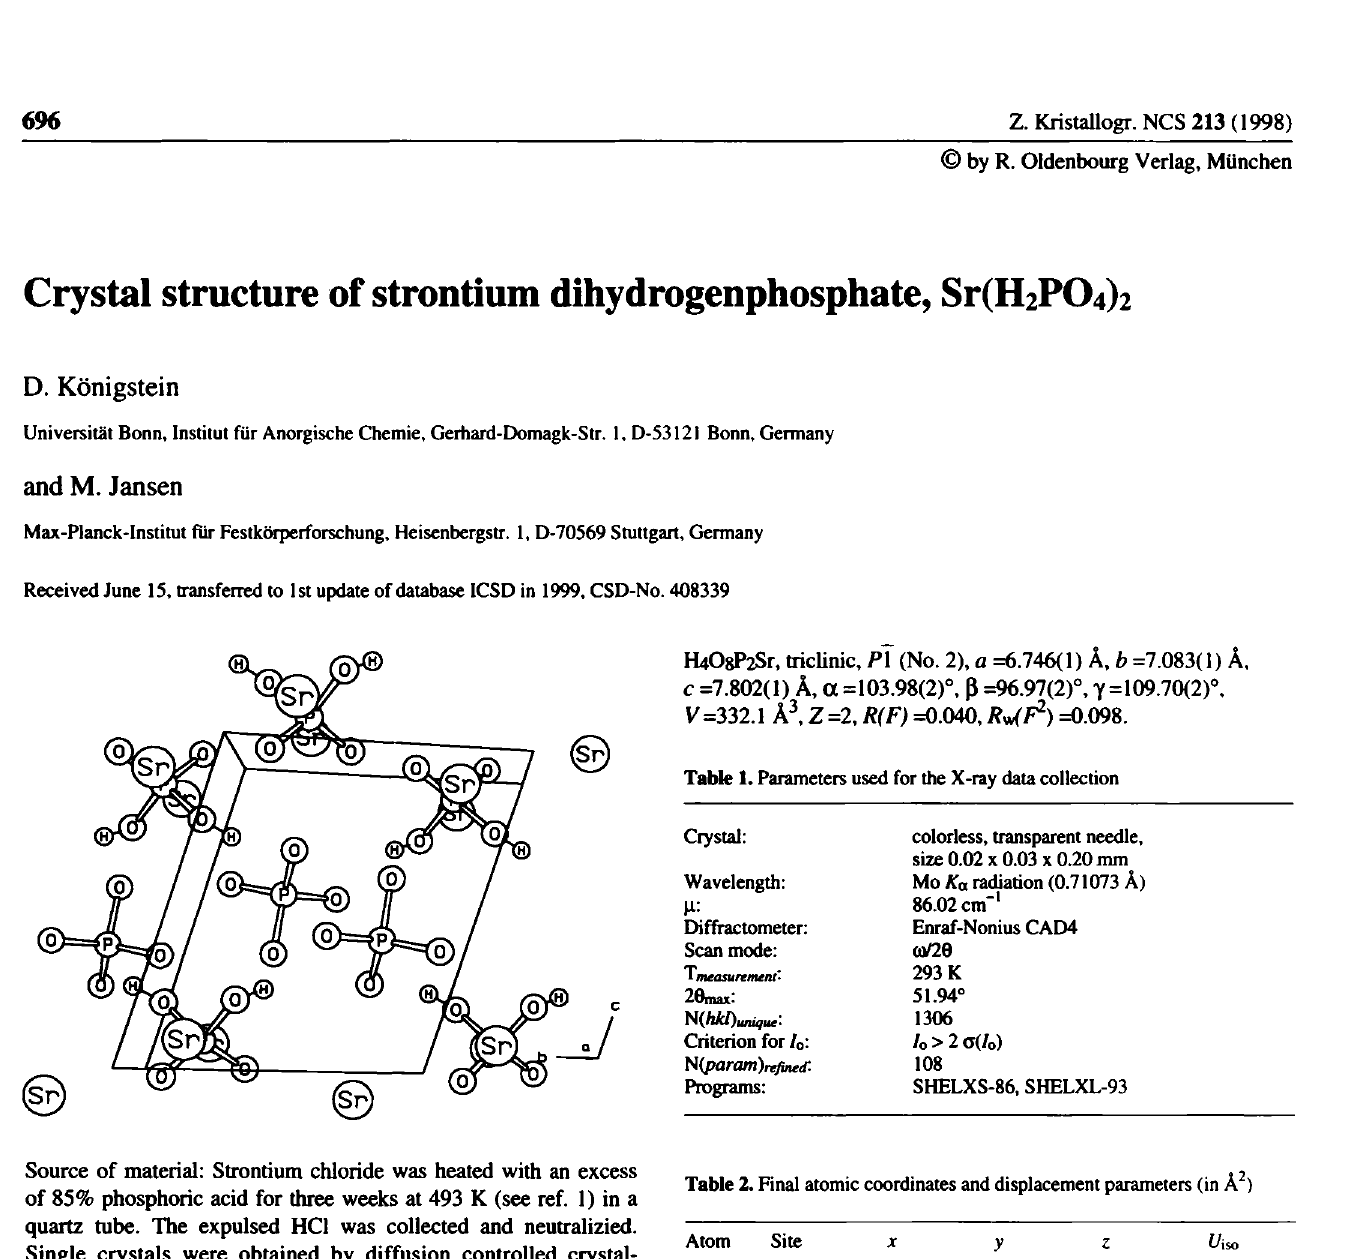
Table 3. Final atomic coordinates and displacement parameters (in